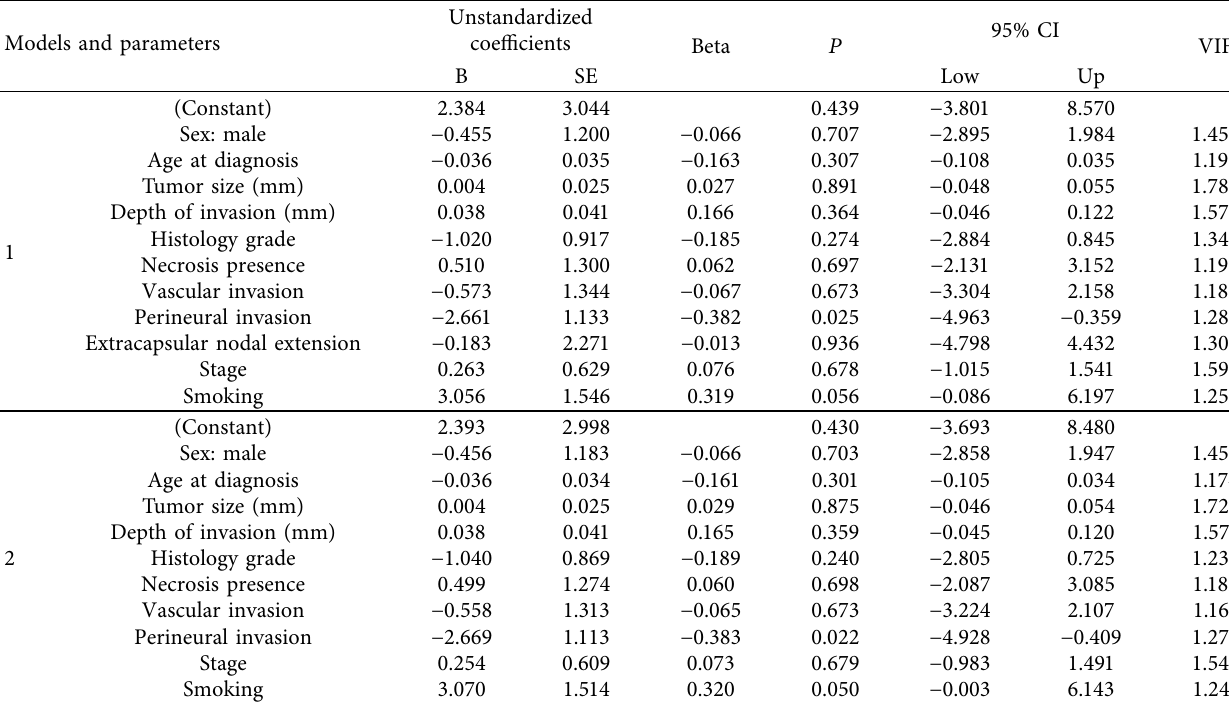
Table 5: Factors associated with the ΔΔ Ct MED15, calculated using the backward-selection stepwise log-level multiple linear regression. Models and